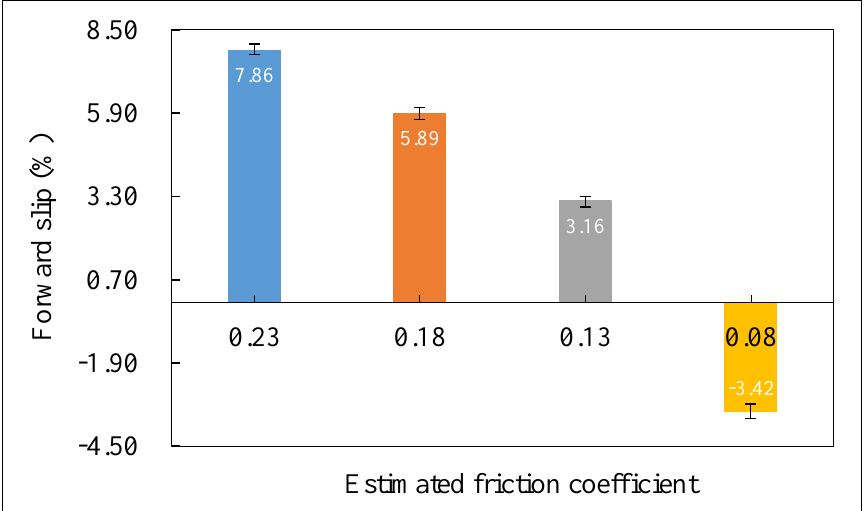
Figure 9. Dependence of forward slip on estimated friction coefficient for the rolling phase with thinner thickness.